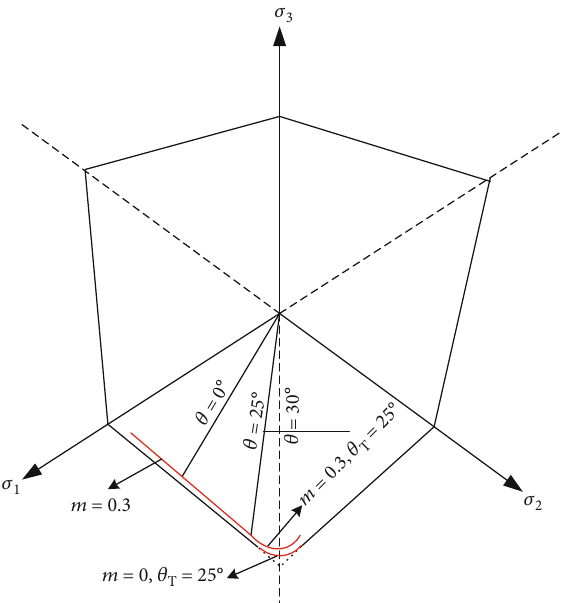
Figure 2: Smooth processing of modi fi ed Mohr-Coulomb criterion in the octahedral